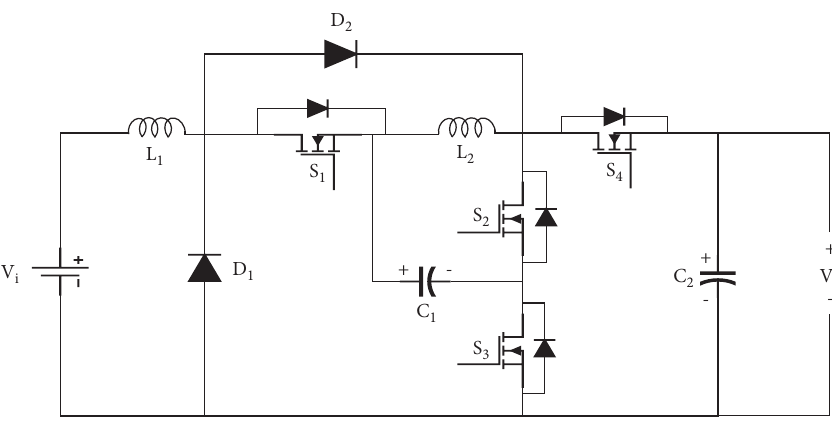
Figure 2: Bidirectional DC-DC quadratic